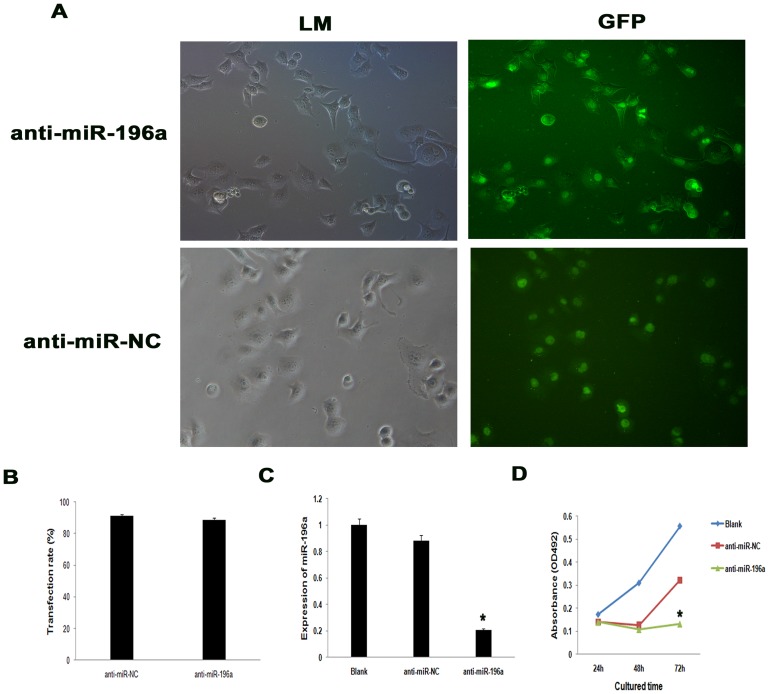
Downregulation of miR-196a inhibited proliferation of pancreatic cancer cell line PANC-1.(A) Transfection of anti-miR-196a and anti-miR-NC in PANC-1. (B) Comparision of transfection rate between anti-miR-196a and anti-miR-NC in PANC-1. The transfection rate of anti-miR-196a was (88.76±2.25)%, while the transfection rate of anti-miR-NC was (91.09±1.77)% (P>0.05). (C) Expression of miR-196a by qRT-PCR. (D) Growth curve among anti-miR-196a, anti-miR-NC and parental PANC-1 cells. Cell proliferation was significantly reduced in anti-miR-196a group compared with that of anti-miR-NC group at 72 h (*, P<0.05). LM: light microscope.